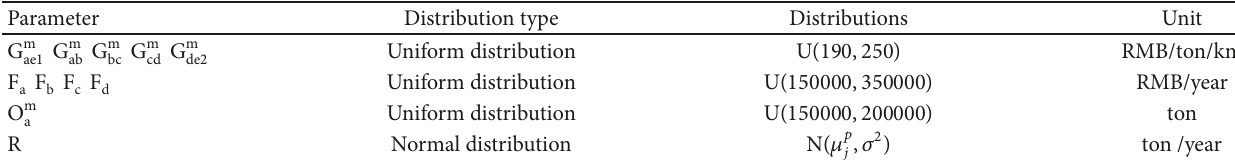
Table 1: Parameters setting for the